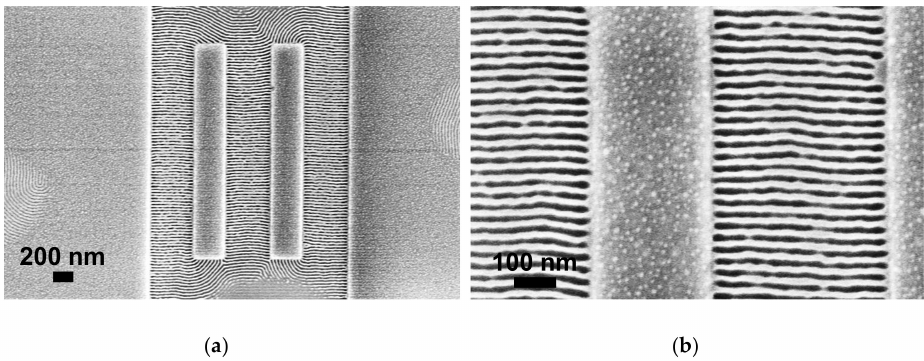
Figure 6. ( a ) SEM top-view micrograph of SiNWs obtained after pattern transfer of PS-b-PMMA; ( b ) zoomed-in